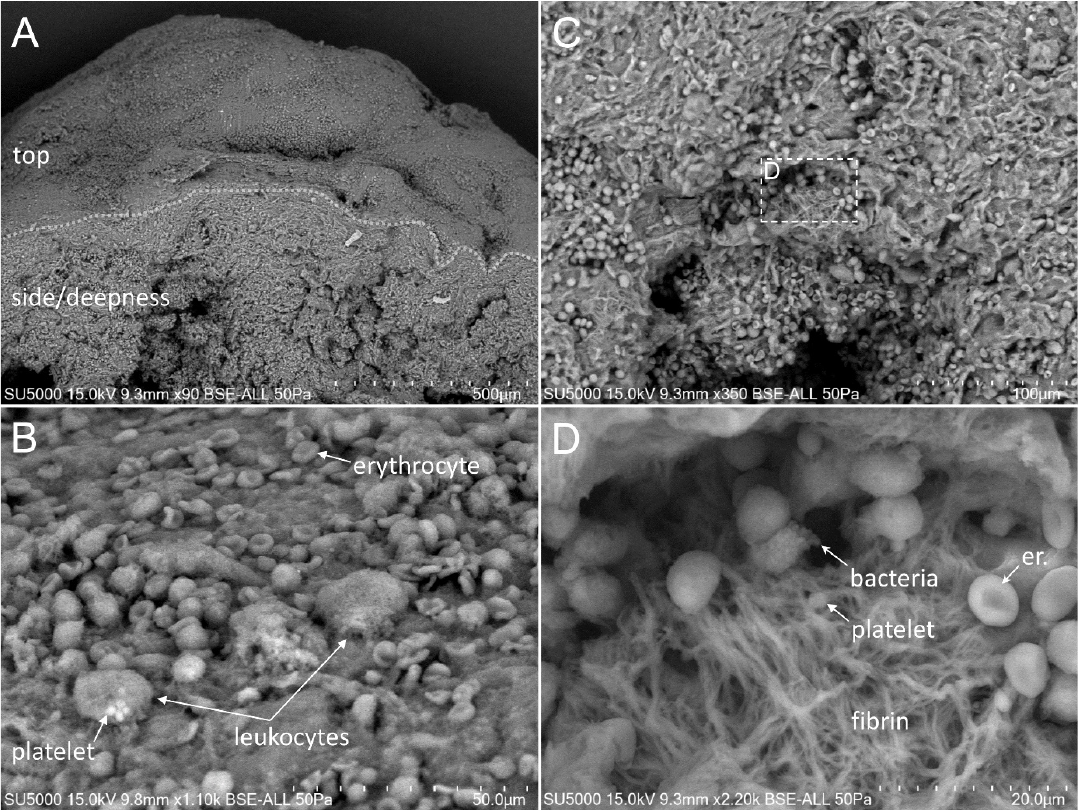
Figure 1. Scanning electron microscopy (SEM) of E. faecalis -infected vegetation. ( A ) Low magnification showing the top and depth of the vegetation. ( B ) Surface view of the vegetation, with numerous erythrocytes and a few platelets and leukocytes. ( C ) Low magnification view of the vegetation side depth, showing the stratified organization of intermingled erythrocytes inside a network of fibrin bundles. ( D ) Zoom-in on the boxed region in ( C ), with erythrocytes, a cluster of bacteria and some platelets mixed with the fibrin network.